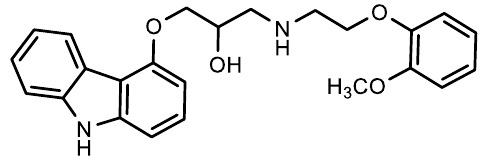
Figure 2. Structure of carvedilol ( 2 )